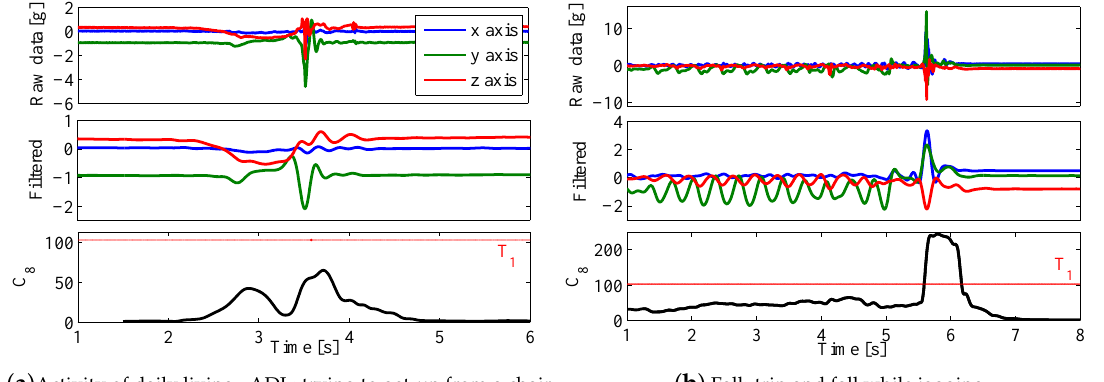
Figure 2. Example of processing and classification. The features are computed after the filtering process of the raw data. ( a ) ADL D11 gives C 8 values below threshold T 1 (horizontal red line); ( b ) Feature C 8 crosses the threshold when the fall in activity F05 is